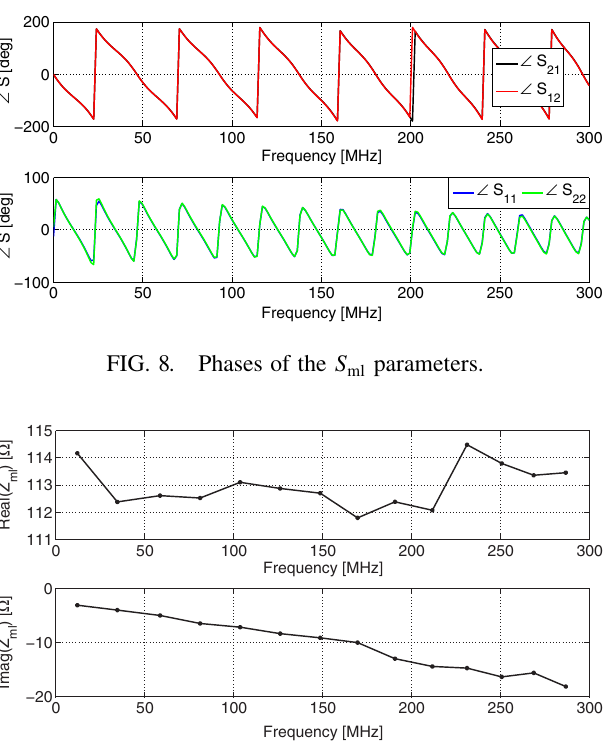
FIG. 9. Real and imaginary part of Z ml for the frequencies where (cid:1) ml L ml ¼ (cid:2) ð 2 k þ 1 Þ = 2 .